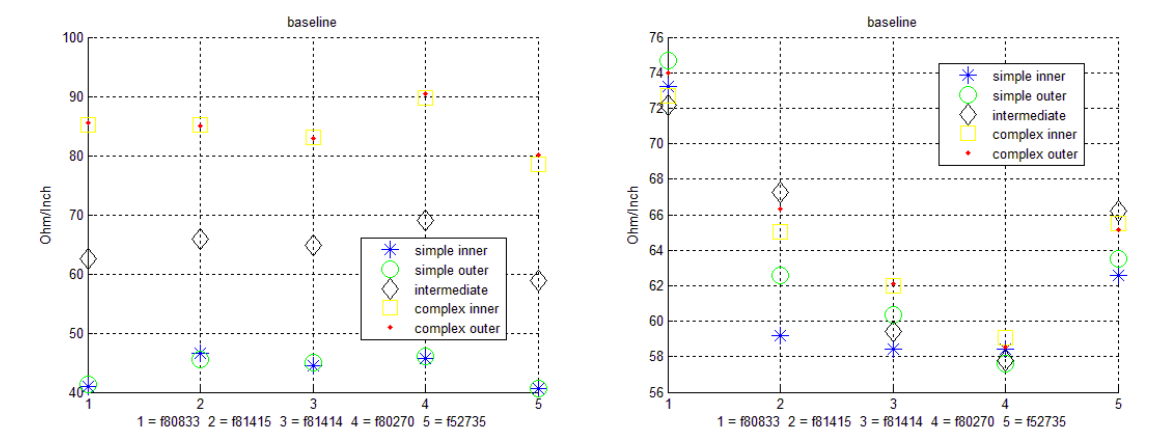
Figure 11. Baseline resistance: ( left ) un-insulated case; ( right ) insulated case.